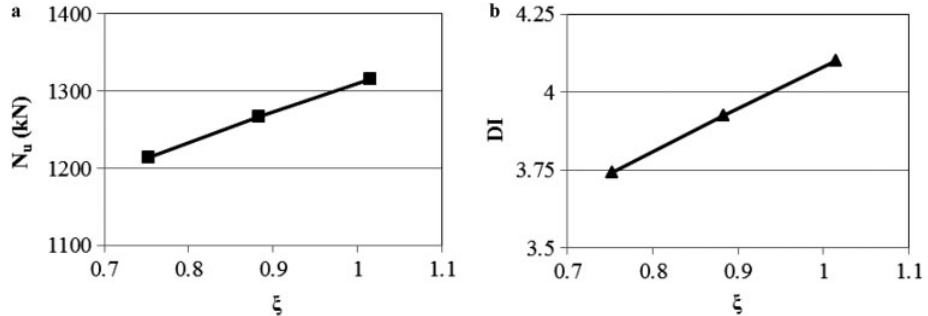
Fig. 11. Confinement effect of steel wall for the columns ( u (cid:4) 1.65 8 & t (cid:4) 3 mm, 3.5 mm, and 4 mm): (a) on ultimate axial load capacity, (b) on